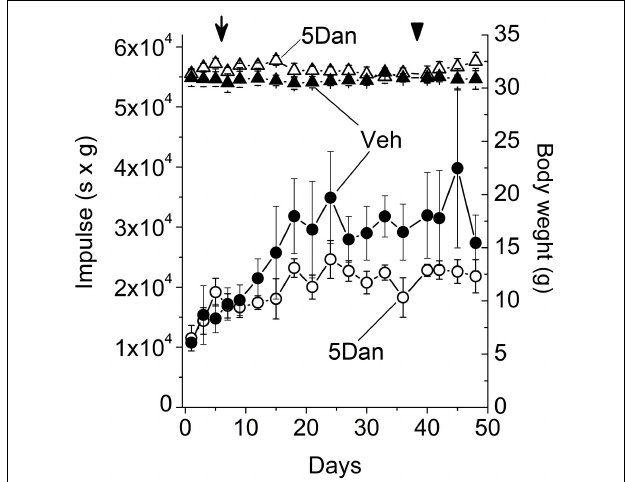
FIGURE 2 | Administration of dantrolene reduces four-limb holding impulse. Holding impulse (hang time × body weight; left axis) in healthy mice injected daily with vehicle (closed circles; n = 4) or 5 mg/kg dantrolene (open circles; n = 4). Injections of both vehicle and dantrolene solution began on day 3 after the beginning of the experiment (arrow) and were administered daily until day 36. Starting from day 37 (arrowhead), the mice in both groups were injected daily with saline. Friedman ANOVA analyses showed that mice injected with 5 mg/kg dantrolene tend to have smaller holding impulse values than mice injected with vehicle alone ( p < 0.05). Closed and open triangles show the body weight of mice (right axis) injected with vehicle (closed triangles; n = 4) or 5 mg/kg dantrolene (open triangles; n = 4). Data are shown as mean ± SE. n, the number of mice in each group. Data are representative of one